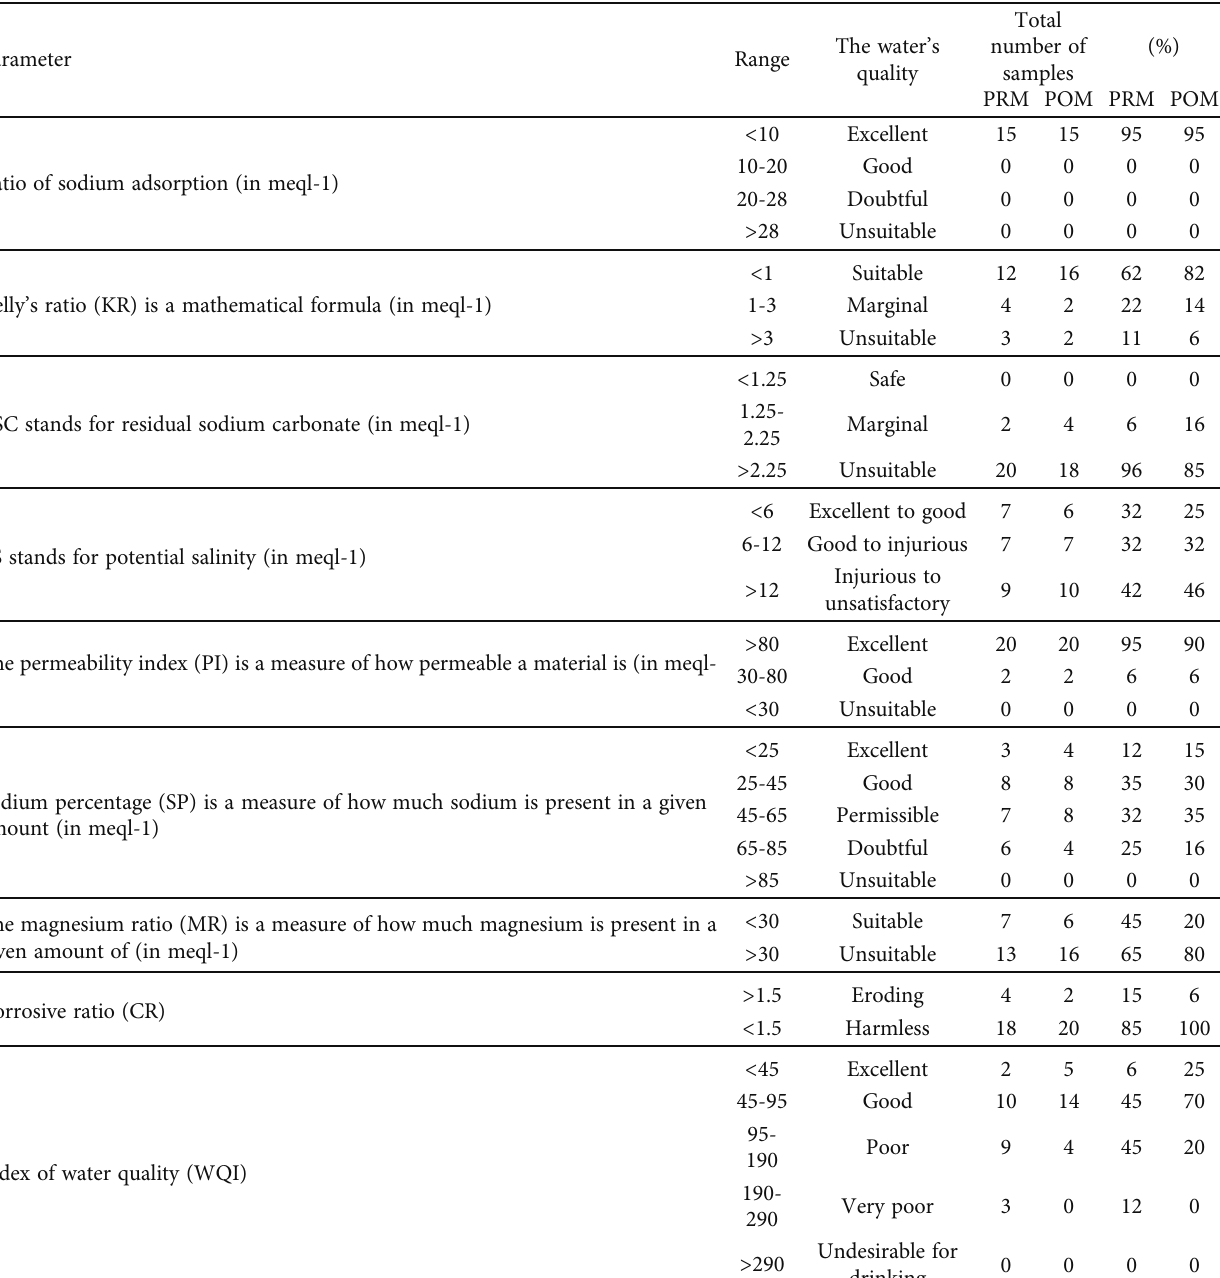
Table 6: Parameters used to classify